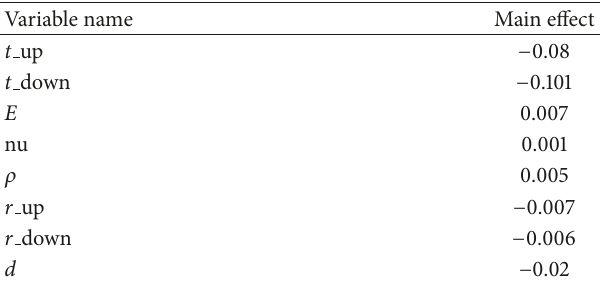
Table 9: The sampling design and the main effect of the value of